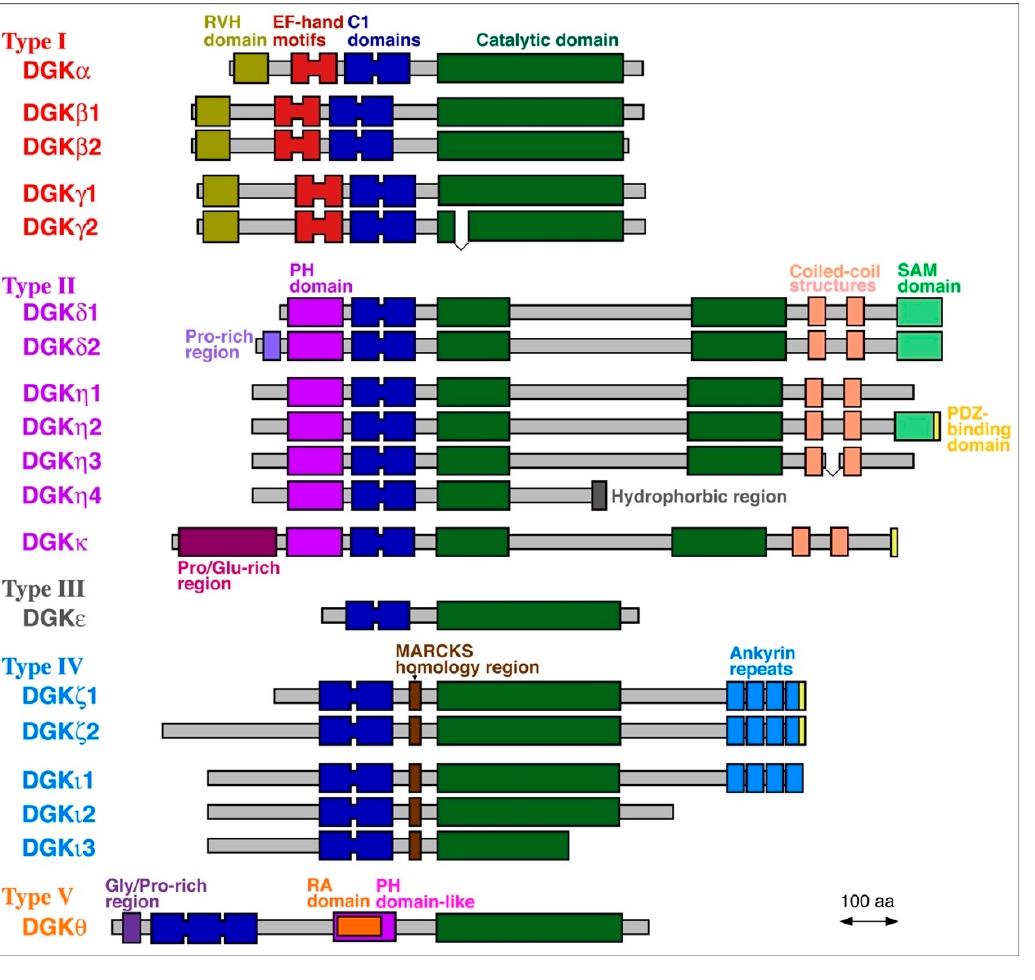
Figure 2. Mammalian DGK family proteins. Alternative splice variants are also shown. MARCKS, myristoylated alanine-rich C-kinase substrate; PDZ, postsynaptic density 95, discs large, zonula occludens-1; PH: pleckstrin homology; RA, Ras-associated; RVH, recoverin homology; SAM, sterile α -motif.